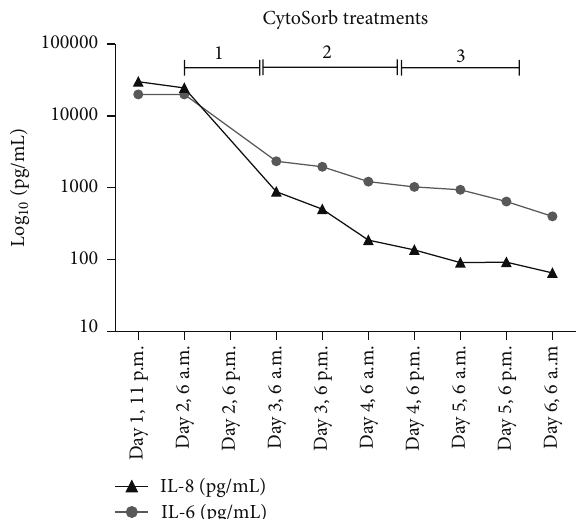
Figure 2: Course of IL-6 and IL-8 throughout the three treatments with the CytoSorb hemoadsorption device. Note that the 𝑦 -axis is depicted in log 10 scale.